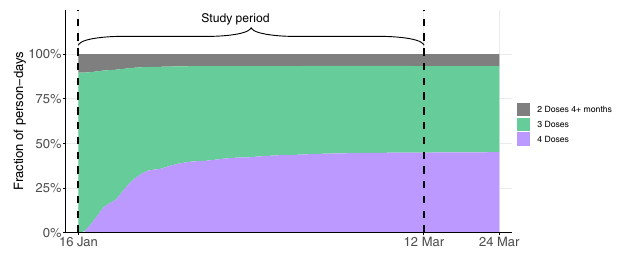
Fig. 3 Vaccination dynamics. Vaccination dynamics of people aged 60 or above during the study period. The dashed vertical lines represent the study period, between January 16, 2022, and March 12,